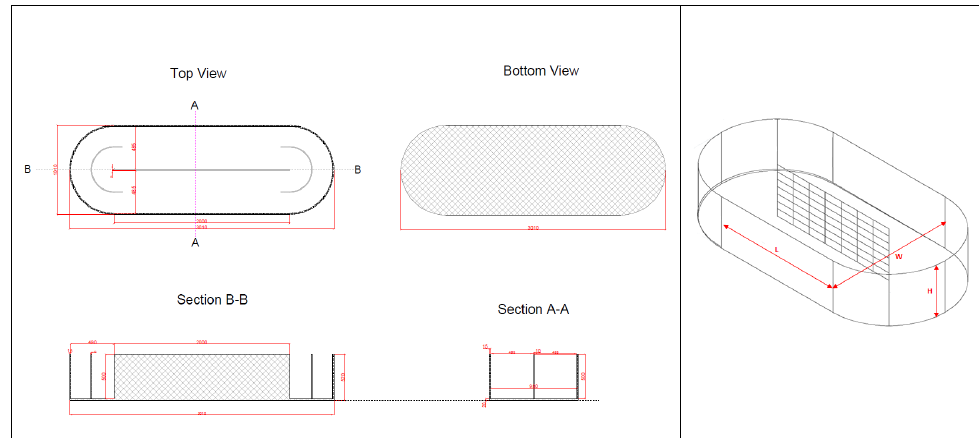
Fig. 2. SMORP single pond